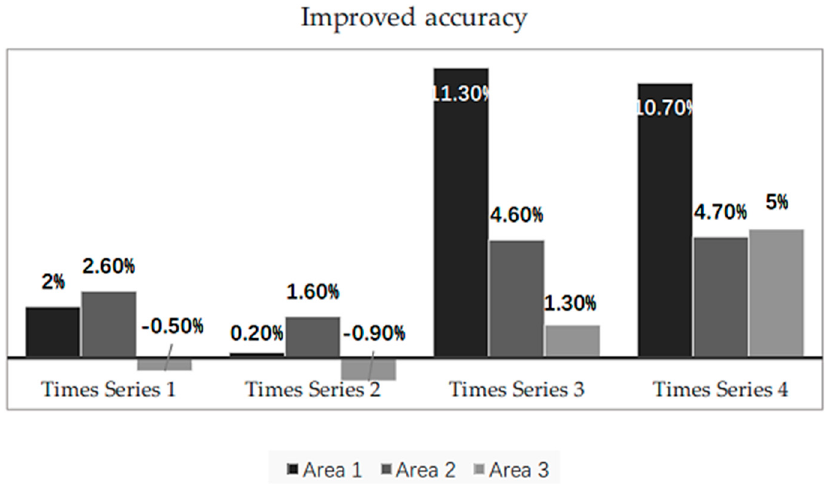
Figure 6. Improved classification accuracy in the study areas after adding mLSTI.